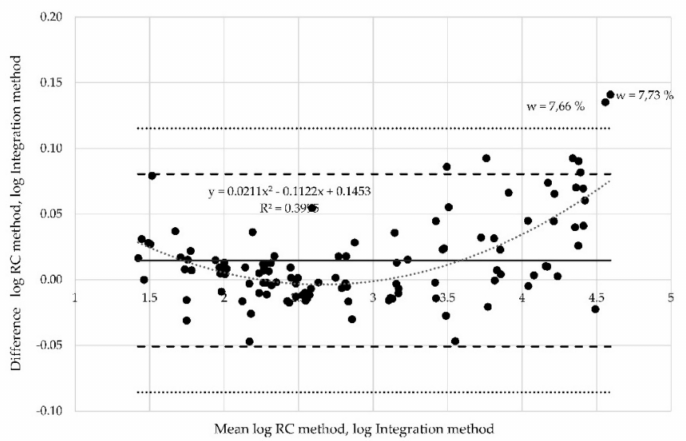
Figure 18. Bland-Altman plot for all samples and all probes—logarithmic